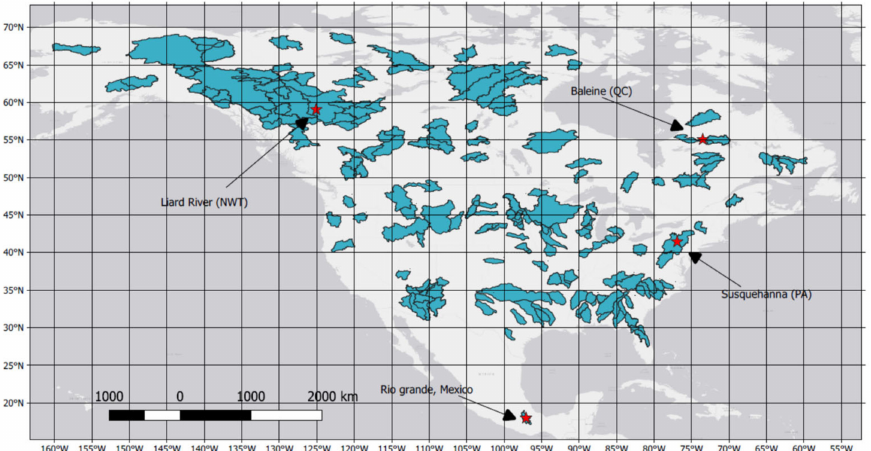
Figure 2. Locations of the 198 large-sized catchments used in this study. The red stars indicate the location of the specific river basins analyzed in Section